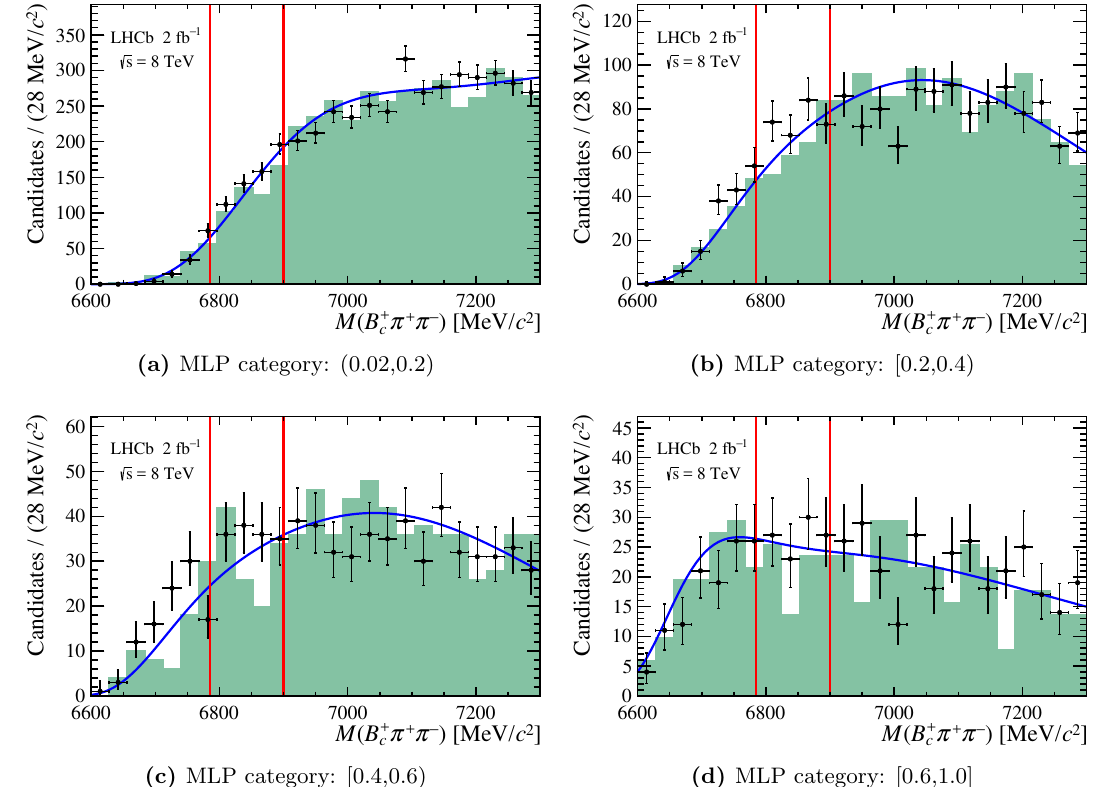
Figure 3. The M ( B + (cid:25) + (cid:25) (cid:0) ) distributions in the same-sign (darkgreen shaded areas) and c data (points with error bars) samples in the range [6600 ; 7300] MeV =c 2 with the background model (blue solid line) overlaid, for the four MLP categories. The areas between the two verti- cal red lines are the signal regions.